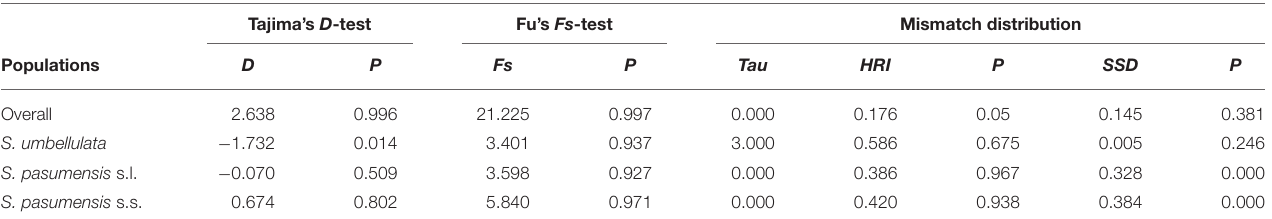
TABLE 5 | Neutrality tests (Tajima’s D, Fu’s F) and mismatch distribution analysis for the combined populations and the two species of Saxifraga umbellulata and S. pasumensis (s.l. and s.s.) based on the cpDNA dataset.